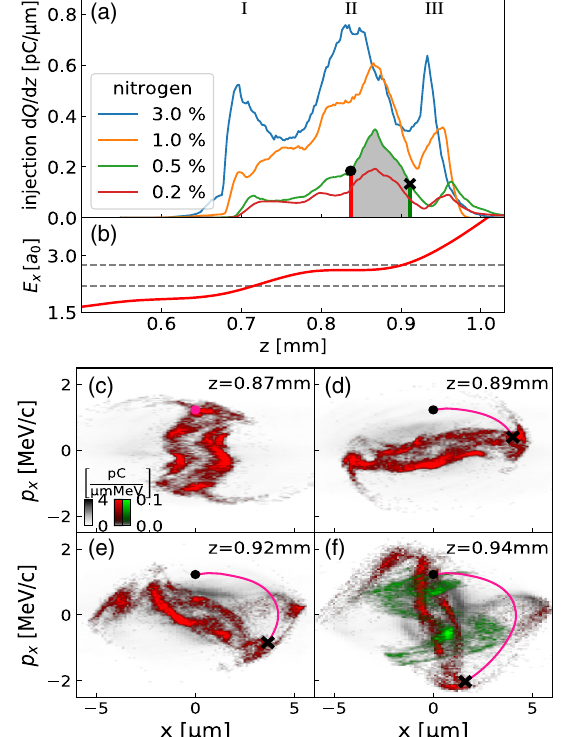
FIG. 4. K -shell ionization and electron injection: (a) shows the injection rate dQ=dz of all trapped electrons and three distinct injections (I, II, and III). (b) indicates the evolution of the laser peak intensity a 0 . The gray dashed lines indicate the ionization threshold for the first and second nitrogen K -shell electrons. (c) – (f) presents the electron transverse phase space distribution ð x; p Þ in the laser polarization plane for the 0.5% nitrogen x doping at z ¼ 0 . 87 ; 0 . 89 ; 0 . 92 , and 0.94 mm. The gray scale represents macroparticles from region II marked in (a). The red and green scale represent slices of earliest and latest injected electrons as indicated in (a), respectively. Extracted from the simulation, the red line represents the path of sample macroparticles that are injected (dot) in the earliest slice at (c) and rotation until the actual time (cross) shown in (d), (e), and (f). The simulations were performed for a plasma density of 4 . 4 × 10 18 cm − 3